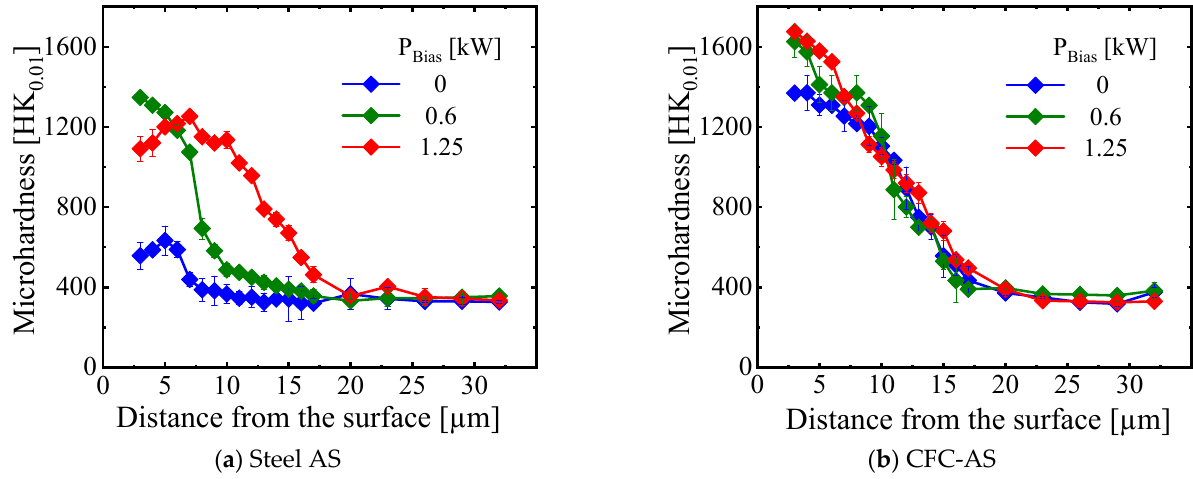
Figure 14. Microhardness depth profiles measured in the cross-sections of samples treated with different bias conditions for a steel AS ( Φ CH4 = 4 slh) ( a ) and a CFC-AS ( b ) at H 2 :N 2 = 1:1, p = 3 mbar, T = 460 °C, Φ Total = 80 slh, and t = 5 h.